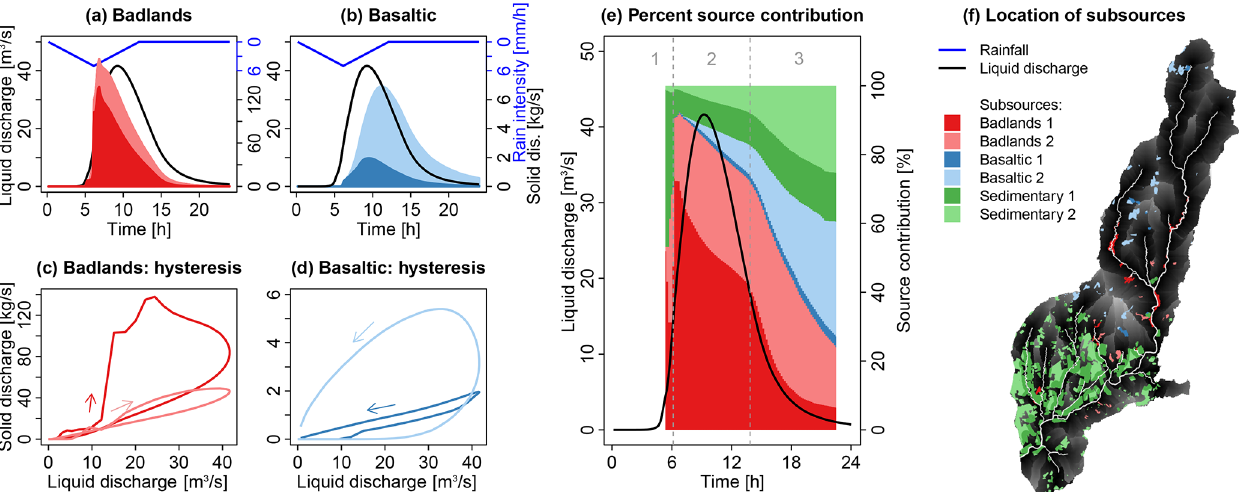
Figure 13. Contribution of subsources that are classified according to their distance to the stream in the Claduègne catchment (Sc. 4b). For a description of the panels, see the caption of Fig.